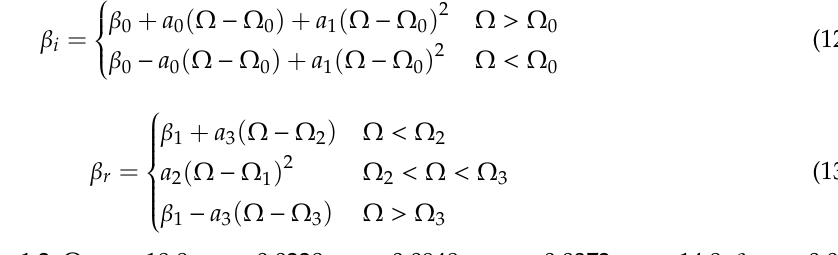
Figure 4. Dependence of R on the nondimensional frequency